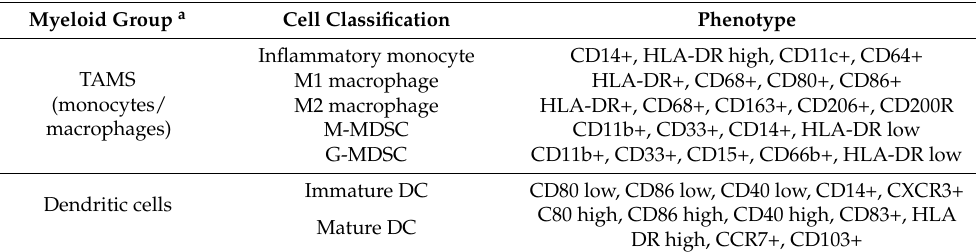
Table 1. Phenotypic characterization of myeloid lineage cells in the ovarian TME.